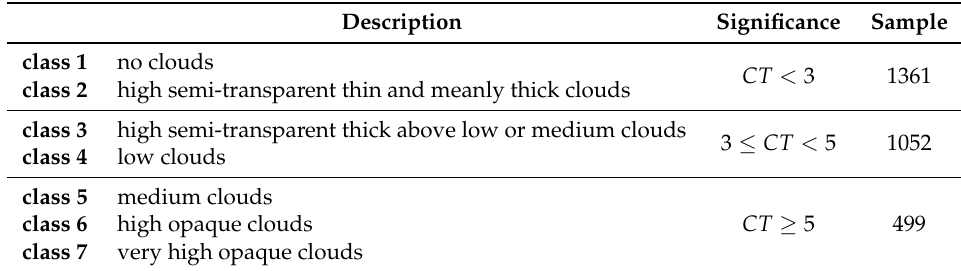
Table 1. Classification of CT product for the analysis of hydrometeors’ contributions to GNSS tropospheric delays. The data samples correspond to number of observations collected during the study period at 13 GNSS stations for specified classes.